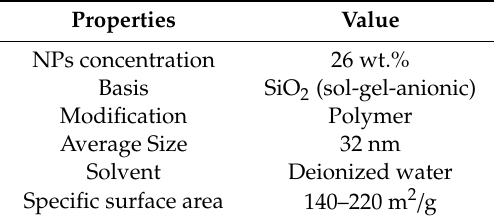
Table 1. Properties of the stock liquid surface-modified silica NPs solution.